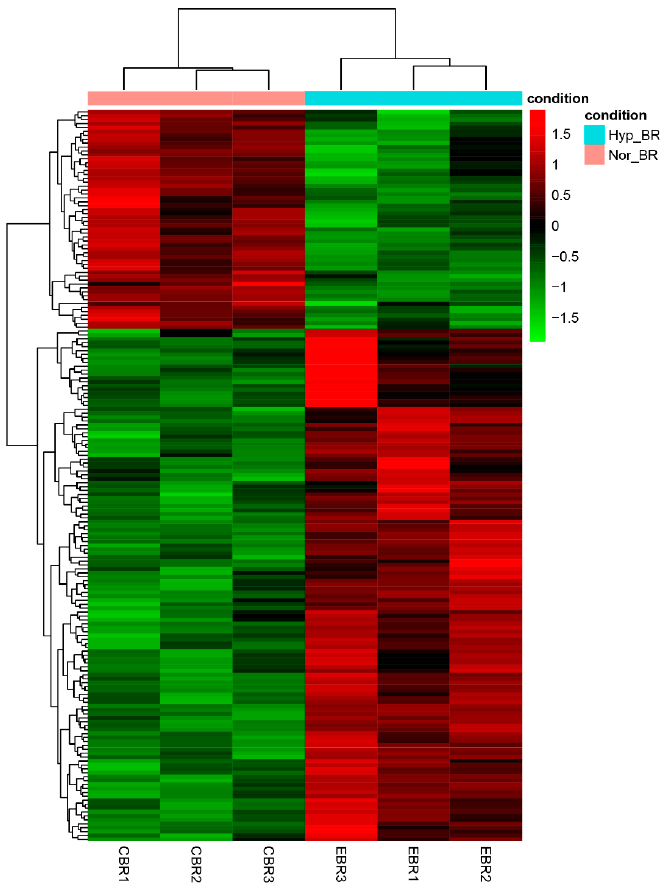
Figure 4. Heatmap of differentially expressed genes between the normoxic and hypoxic groups. Red represents upregulated genes and green indicates downregulated genes. Heatmap was drawn based on the normalized expression data (Supplementary Information Table